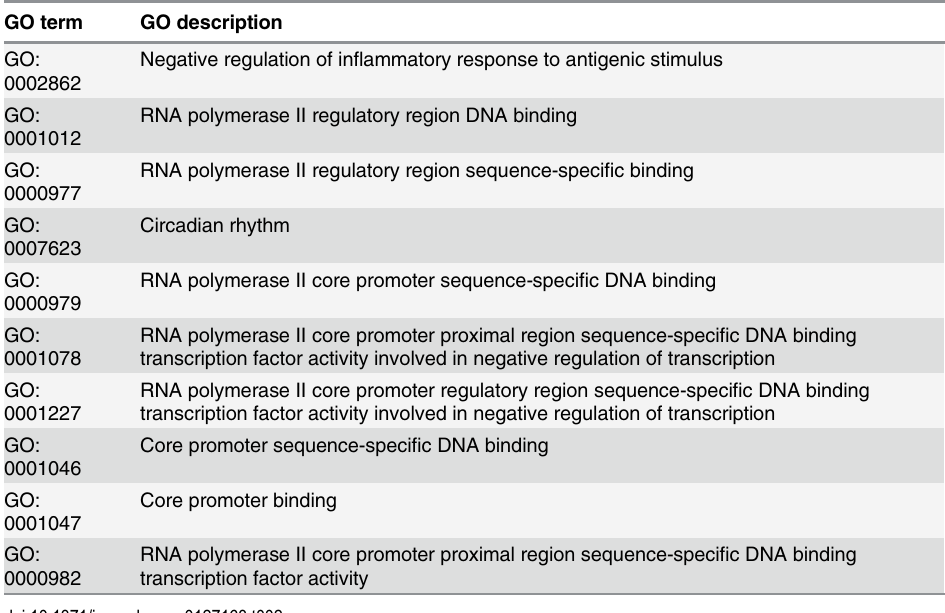
Table 2. Gene ontology terms overrepresented within genes differentially regulated at 5 days post-